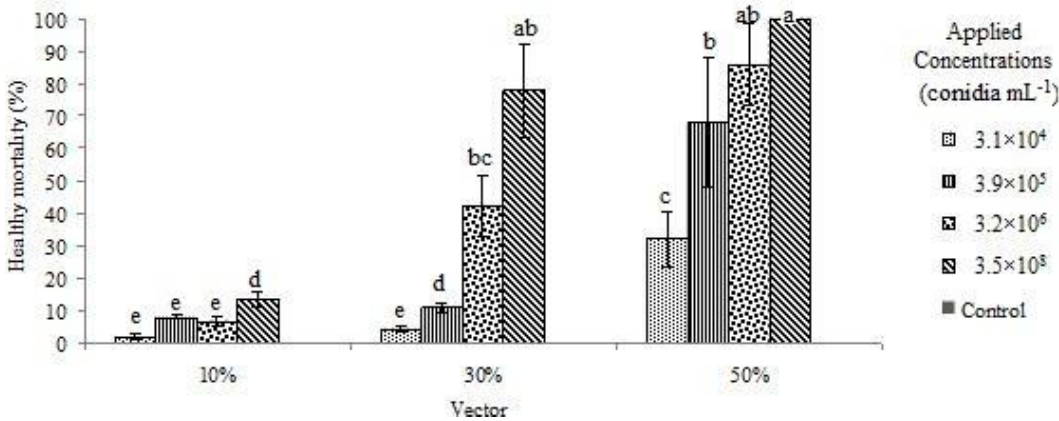
Table 1. The level of LT